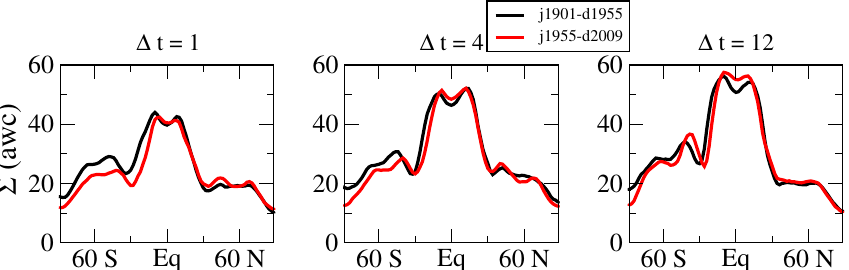
Figure 4. Zonal sum of the AWC for the NOAA networks built by using the BP methodology with 1t =1, 1t =4 and 1t =12, for both time periods (black: 1901–1955, red: 1955–2009).